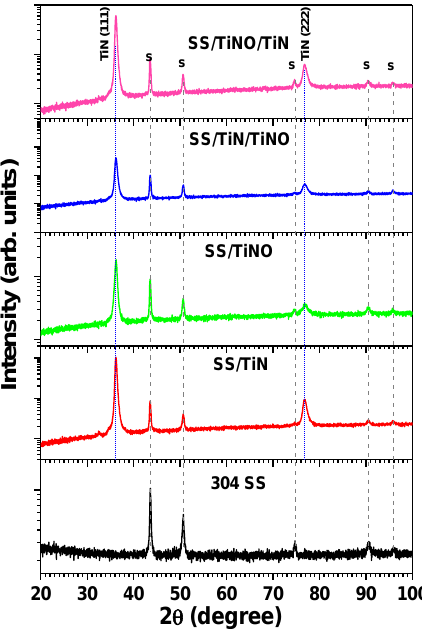
Figure 1. XRD di ff raction patterns of investigated samples. Figure 1. XRD diffraction patterns of investigated samples.